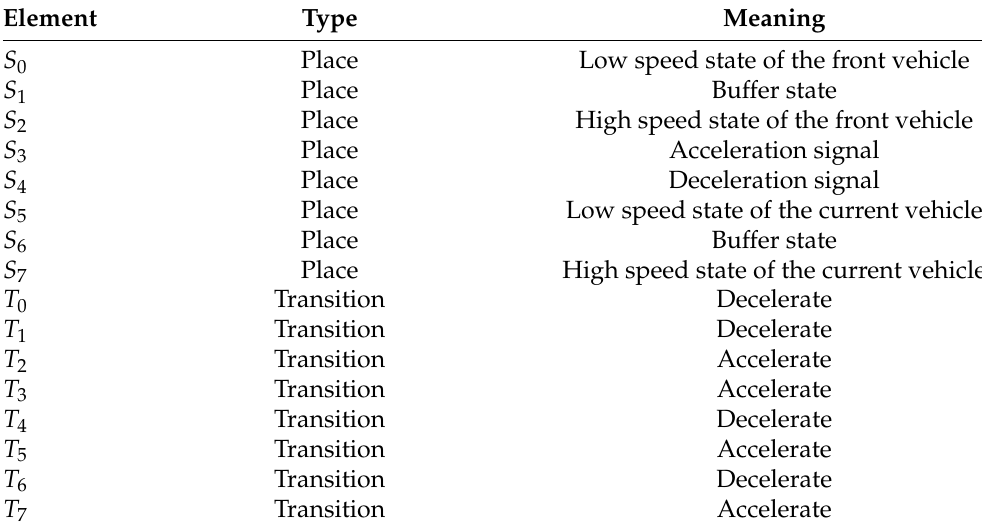
Figure 2. Petri net of ACC. Table 1. The list of elements of Petri net of